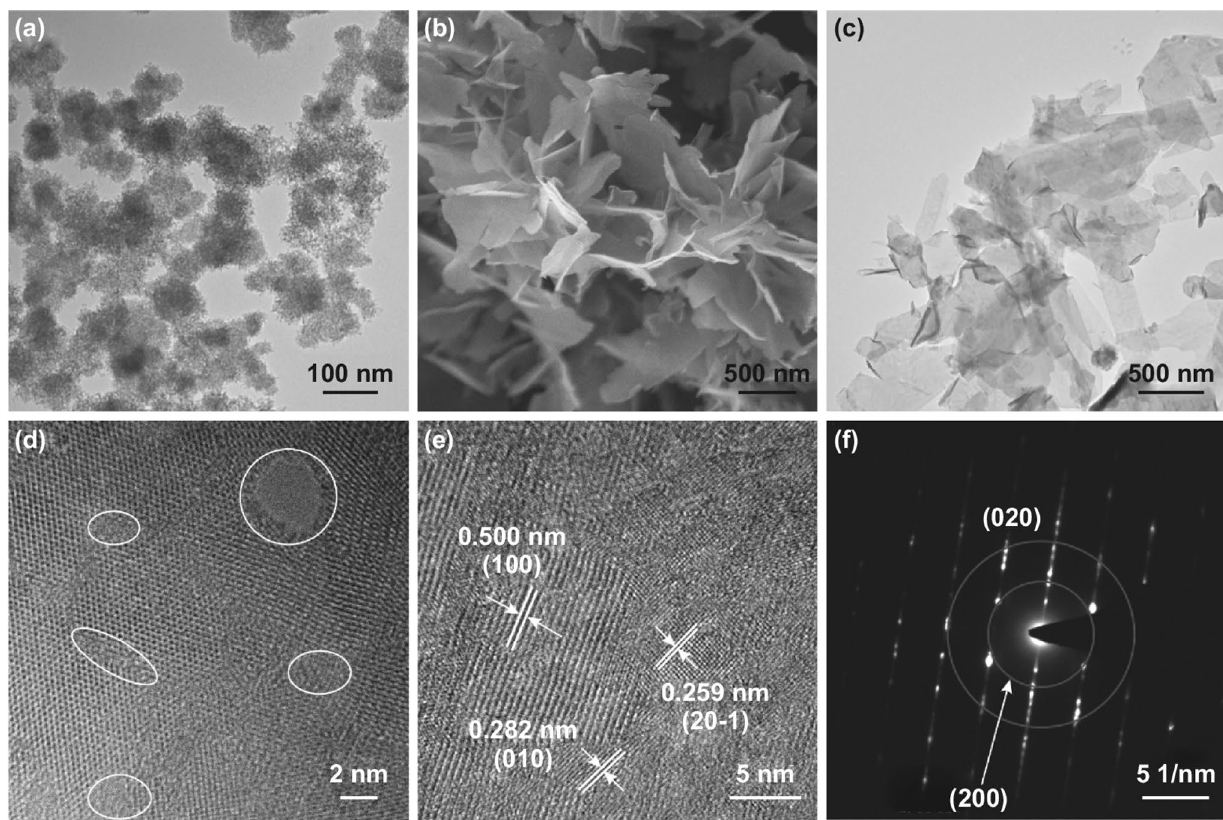
Fig. 2 a TEM image of Mn x Si y O z . b SEM image, c TEM image, d, e HRTEM images, and f corresponding SAED pattern of Na 0.55 Mn 2 O 4 ·0.57H 2